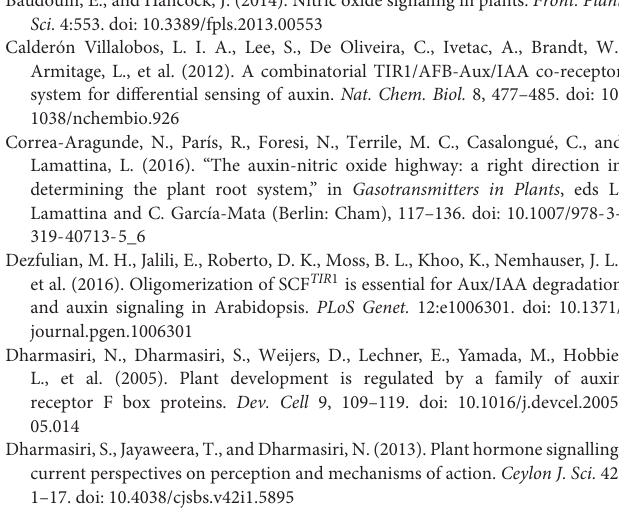
Supplementary Figure 1 | MS/MS spectrum of TIR1 tryptic peptide including carbamidomethylated Cys140 peptide. TIR1 was treated with GSNO and subjected to a redox switch, substituting reversibly oxidized Cys to carbamidomethylation. Supplementary Figure 2 | Pull-down reactions were performed using in vitro synthesized TIR1-myc and recombinant GST-ASK1 or GST proteins. Interacting TIR1 protein was detected using an anti-myc antibody (upper panel). Coomassie blue-stained GST–ASK1/GST was used as a loading control (lower panel). Supplementary Figure 3 | Sequence alignment of A. thaliana TIR1, AFB1-5, and COI1. Critical ligand-, InsP6/ phosphate-, and substrate-contacting residues are indicated by colored dots as described in the key. Supplementary Figure 4 | Cartoon representation of the ASK1-TIR1 crystal structure. A detailed view of the interface of interaction ASK1-TIR1 including the distance between selected residues is shown. ASK1 and TIR1 are represented in magenta and light blue, respectively. Cys118 ASK1 is colored in yellow; His16 and Val17 TIR1 are colored in green. Crystallographic data were obtained from Protein Data Bank, 2p1q. Supplementary Figure 5 | Alignment of selected COI1 orthologs showing the conservation in Cys487. Color code: dark gray: 100% similarity; medium gray: 80–100% similarity; light gray: 60–80% similarity; white: less than 60% similar. Supplementary Figure 6 | Distances between potentially S-nitrosable Cys and key residues in COI1. (A) Distances between Cys60 (red) and Lys81 (yellow). (B) Distances between Cys148 (red) and Arg121 (yellow). (C) Distances between Cys406 (red) and Arg409 (yellow). The distances between atoms are measured in